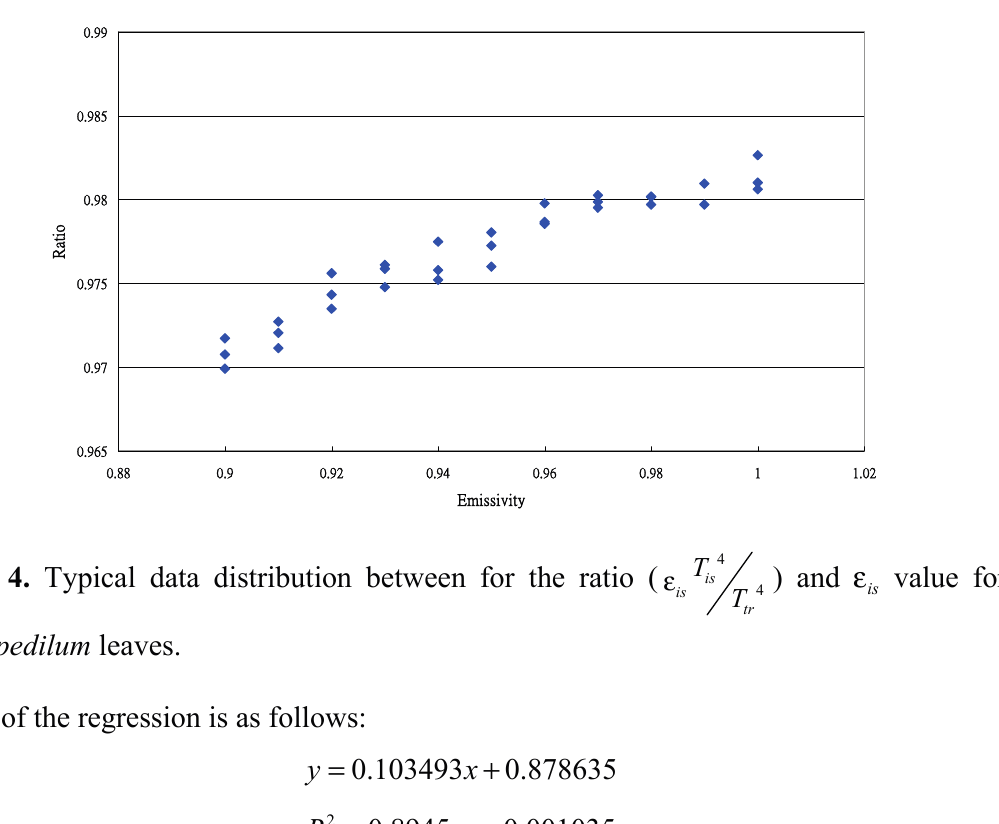
Figure 4. Typical data distribution between for the ratio ( T Paphiopedilum